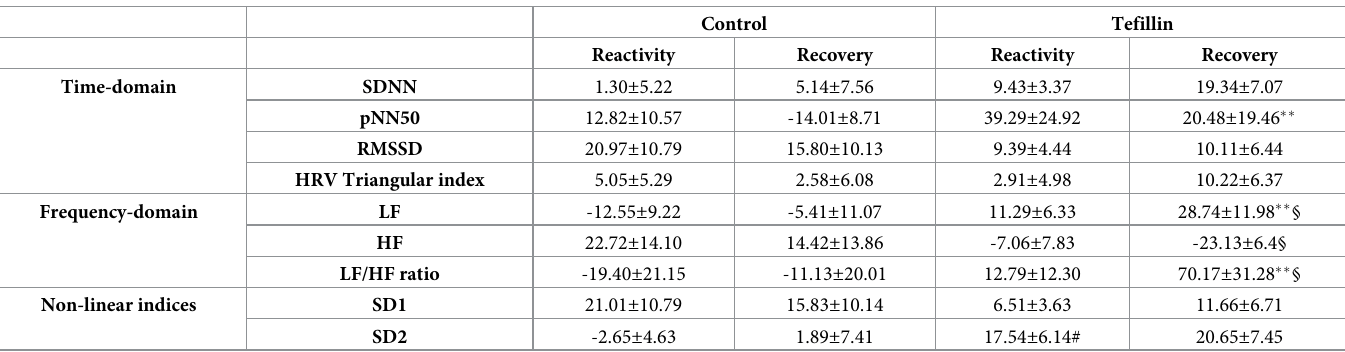
Table 3. Average percent change from baseline for HRV